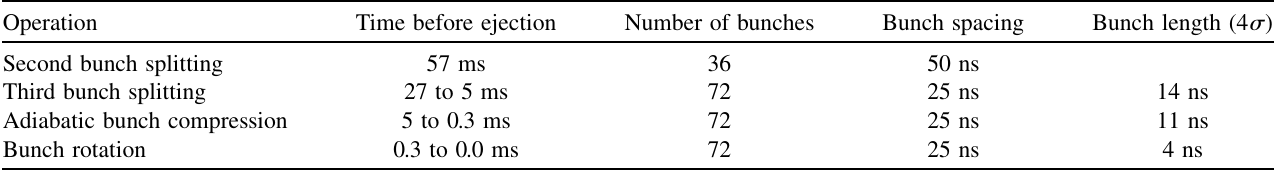
TABLE I. Summary of the bunch length evolution during the last milliseconds in the PS cycle.